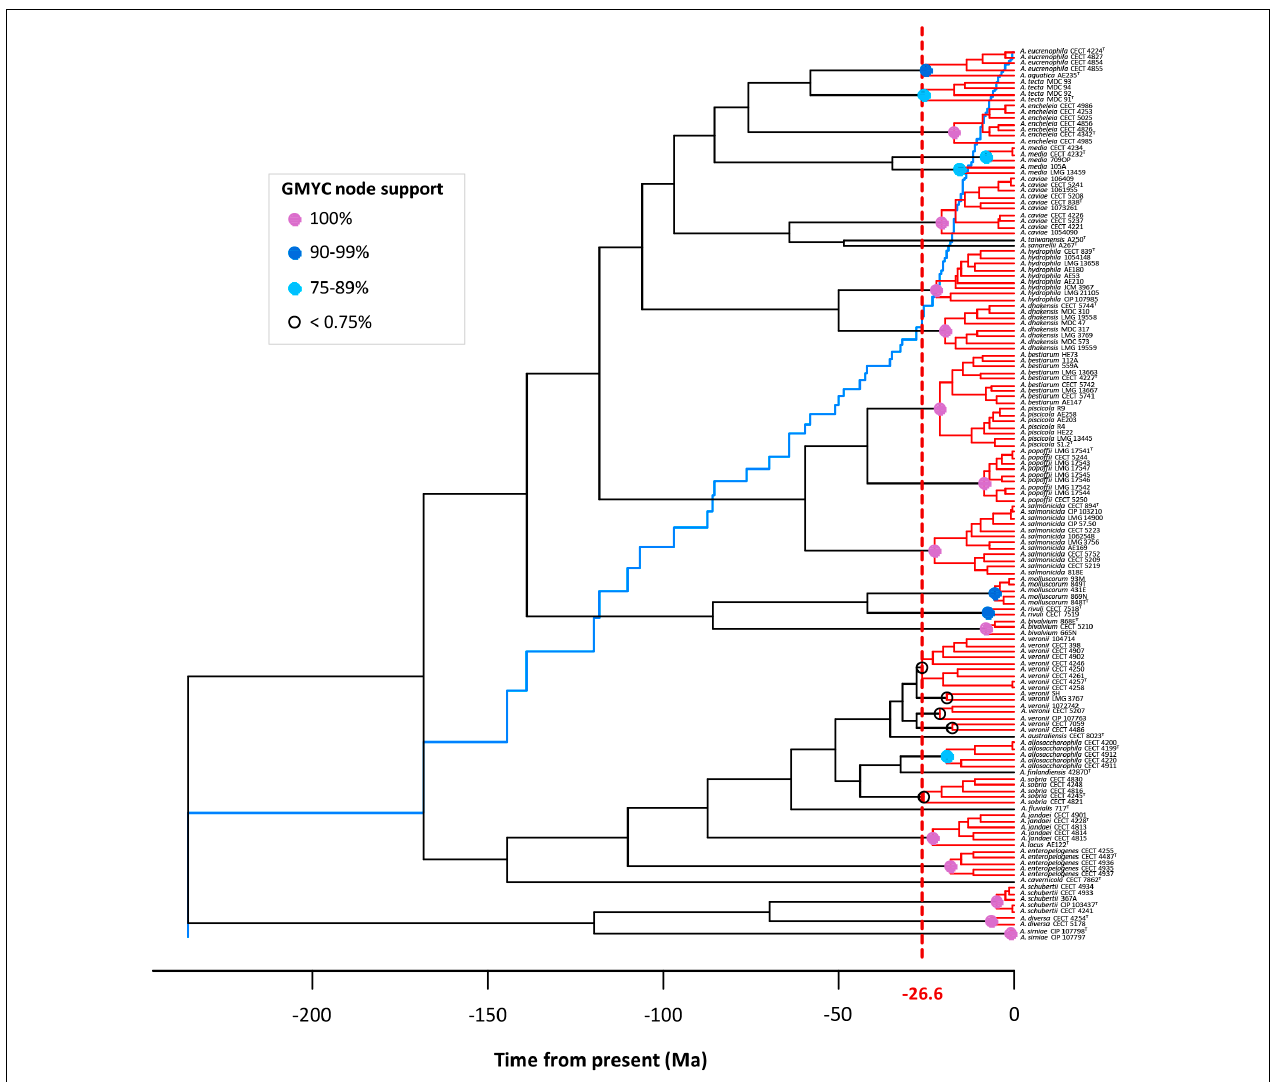
FIGURE 6 | GMYC analysis. The LTT plot (blue line) showing a clear abrupt change from the threshold (vertical dashed red line). Node support of the main GMYC clusters (red) is illustrated by colored circles (see legend in